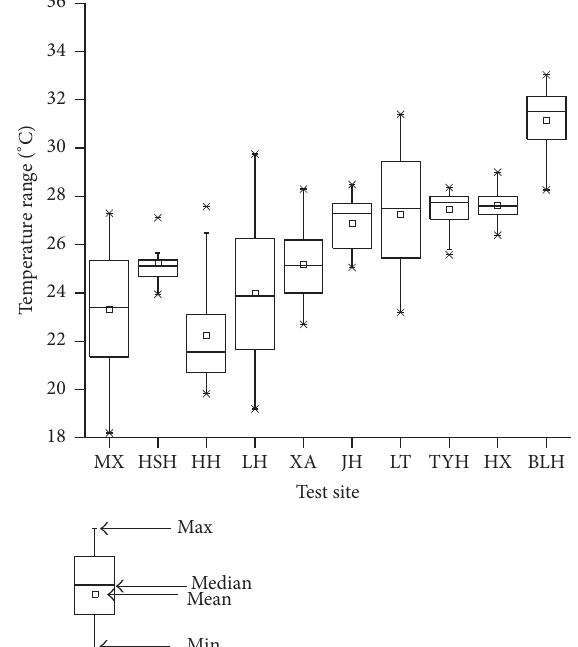
Figure 5: Box plot of sediment temperatures in testing